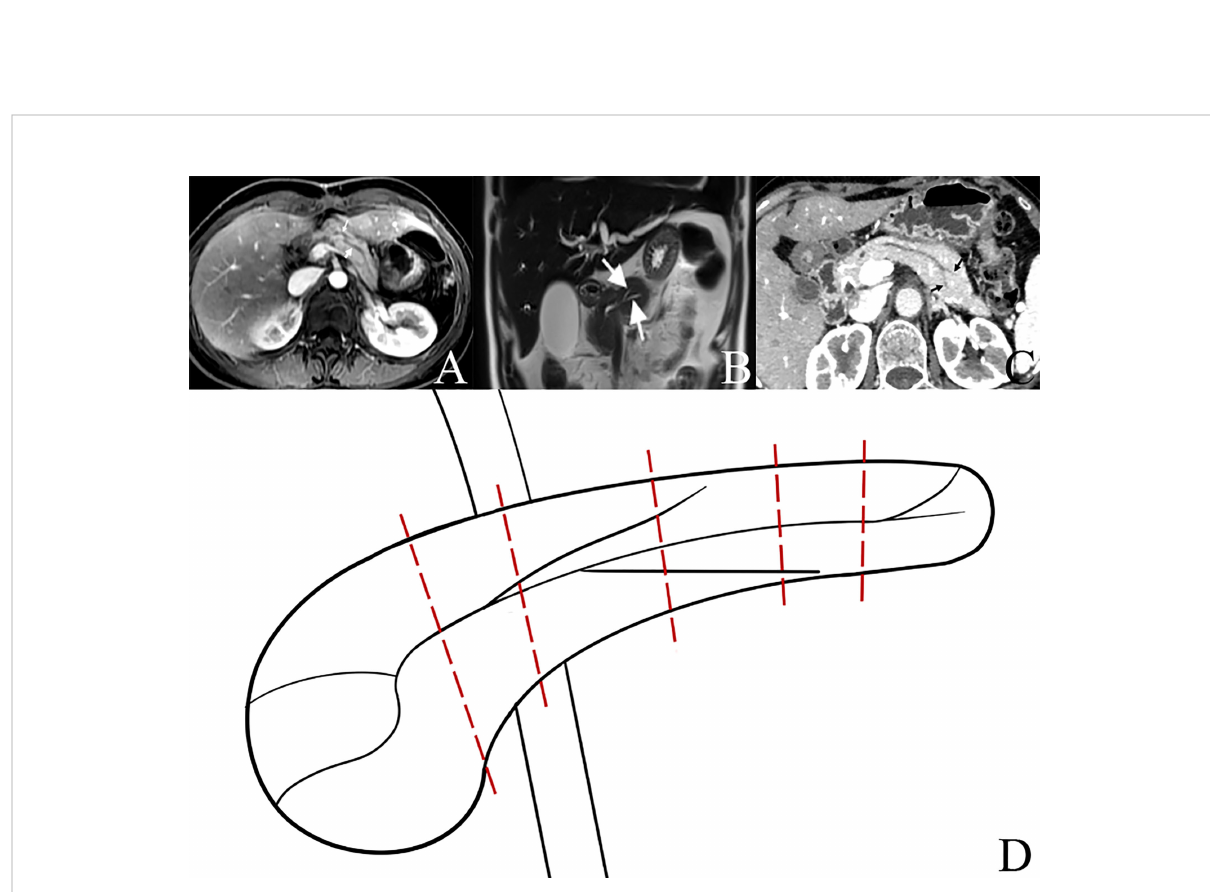
FIGURE 6 Bi fi d pancreatic duct at the neck, body, and tail of pancreas. (A) Bi fi d pancreatic duct (two white arrows) at the neck of pancreas. (B) Bi fi d pancreatic duct (two white arrows) at the body of pancreas. (C) Bi fi d pancreatic duct (two black arrows) at the tail of pancreas. (D) Diagram of bi fi d pancreatic duct at different locations of pancreas; different pancreatic transections result in different numbers of pancreatic duct ori fi ces in the remnant of pancreas during